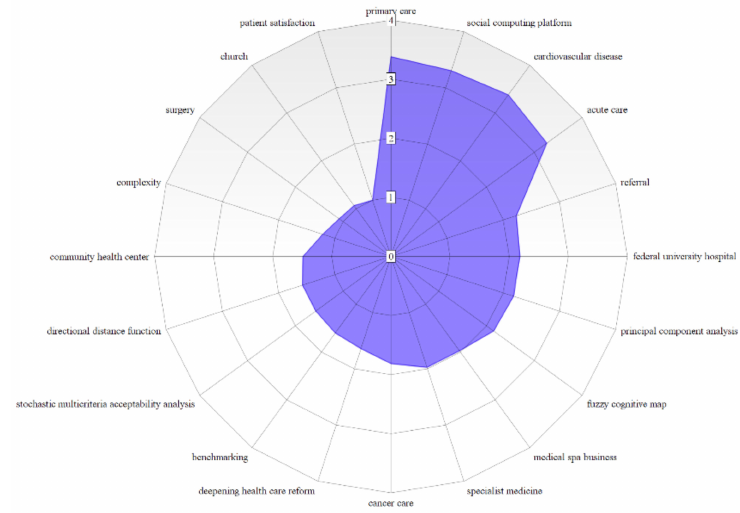
Figure 11. Hot Topics for a Research Agenda in the Blue